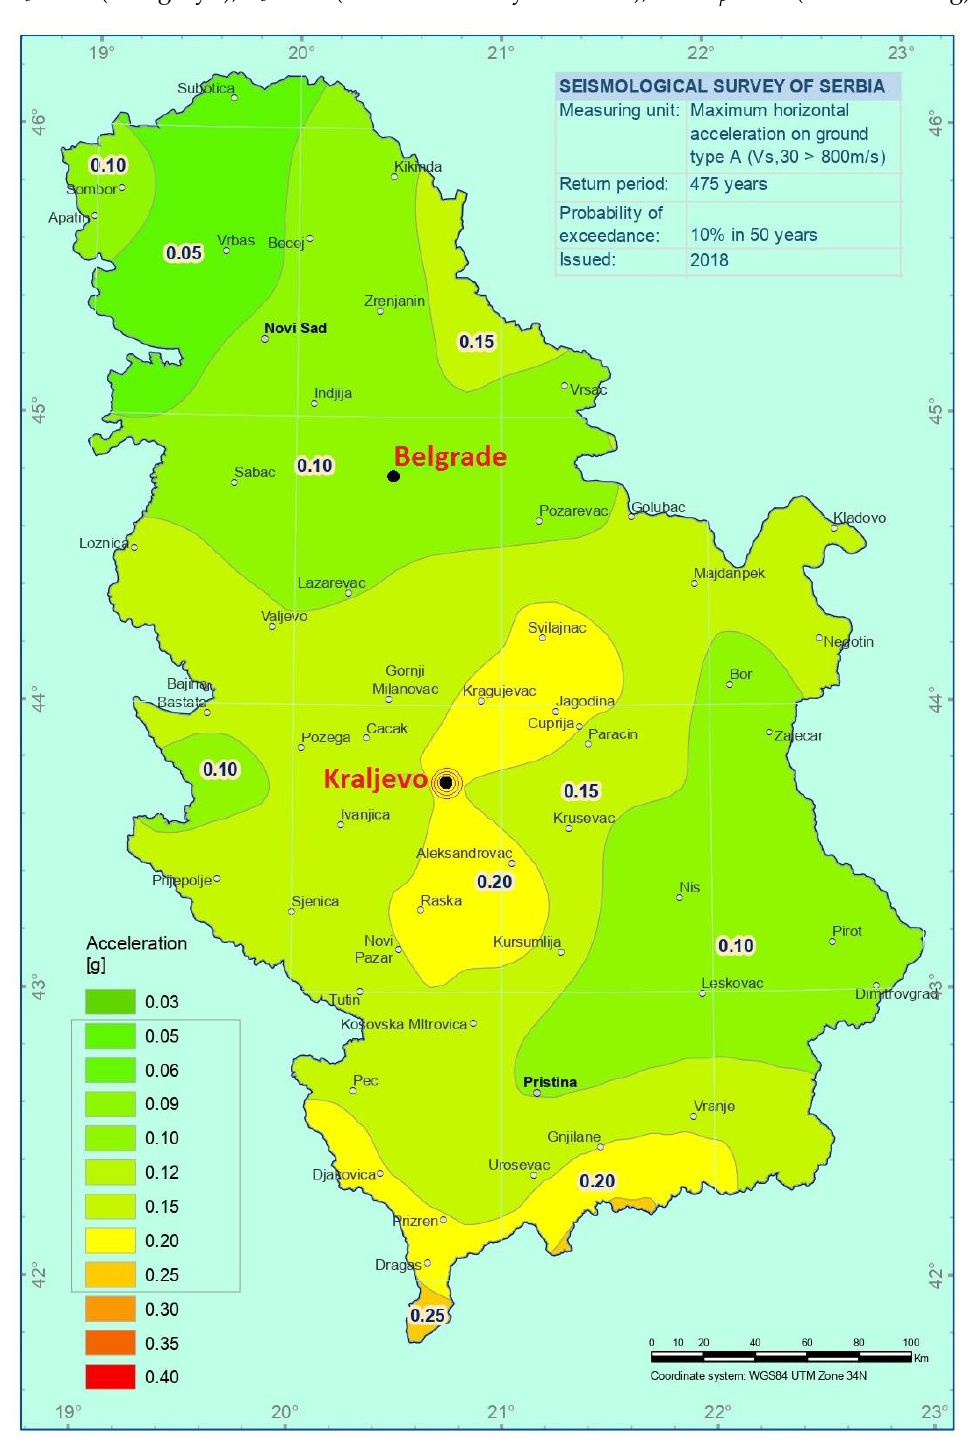
Figure 1. Seismic hazard map for Serbia showing the design PGA values for an earthquake with 10% probability of exceedance in 50 years, according to Eurocode 8 [22].